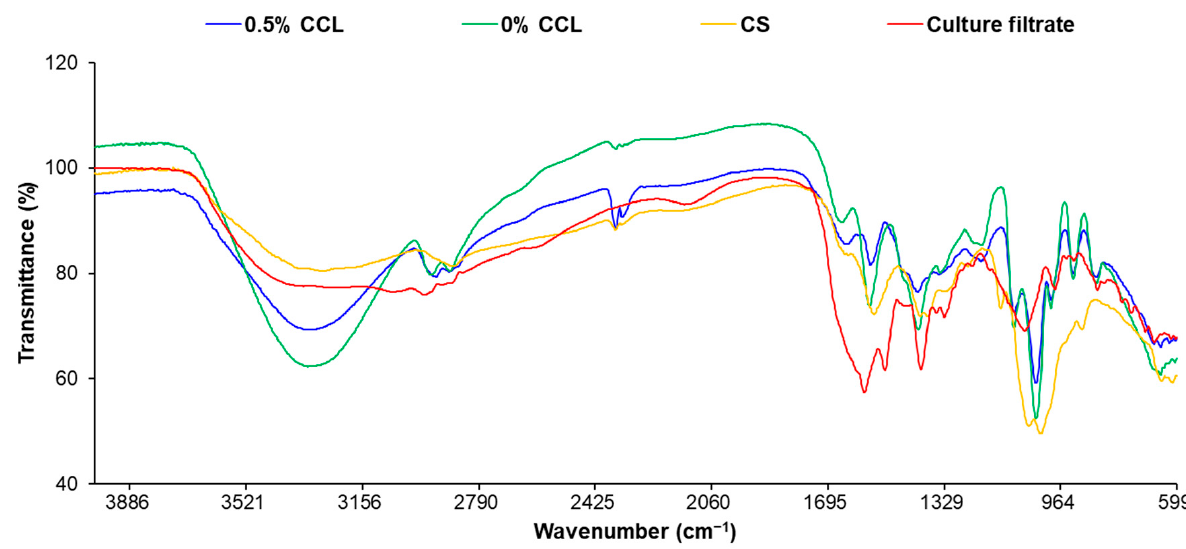
Figure 5. FT-IR spectra of 0% and 0.5% CCL, CS, and culture filtrate of Bs KB21.